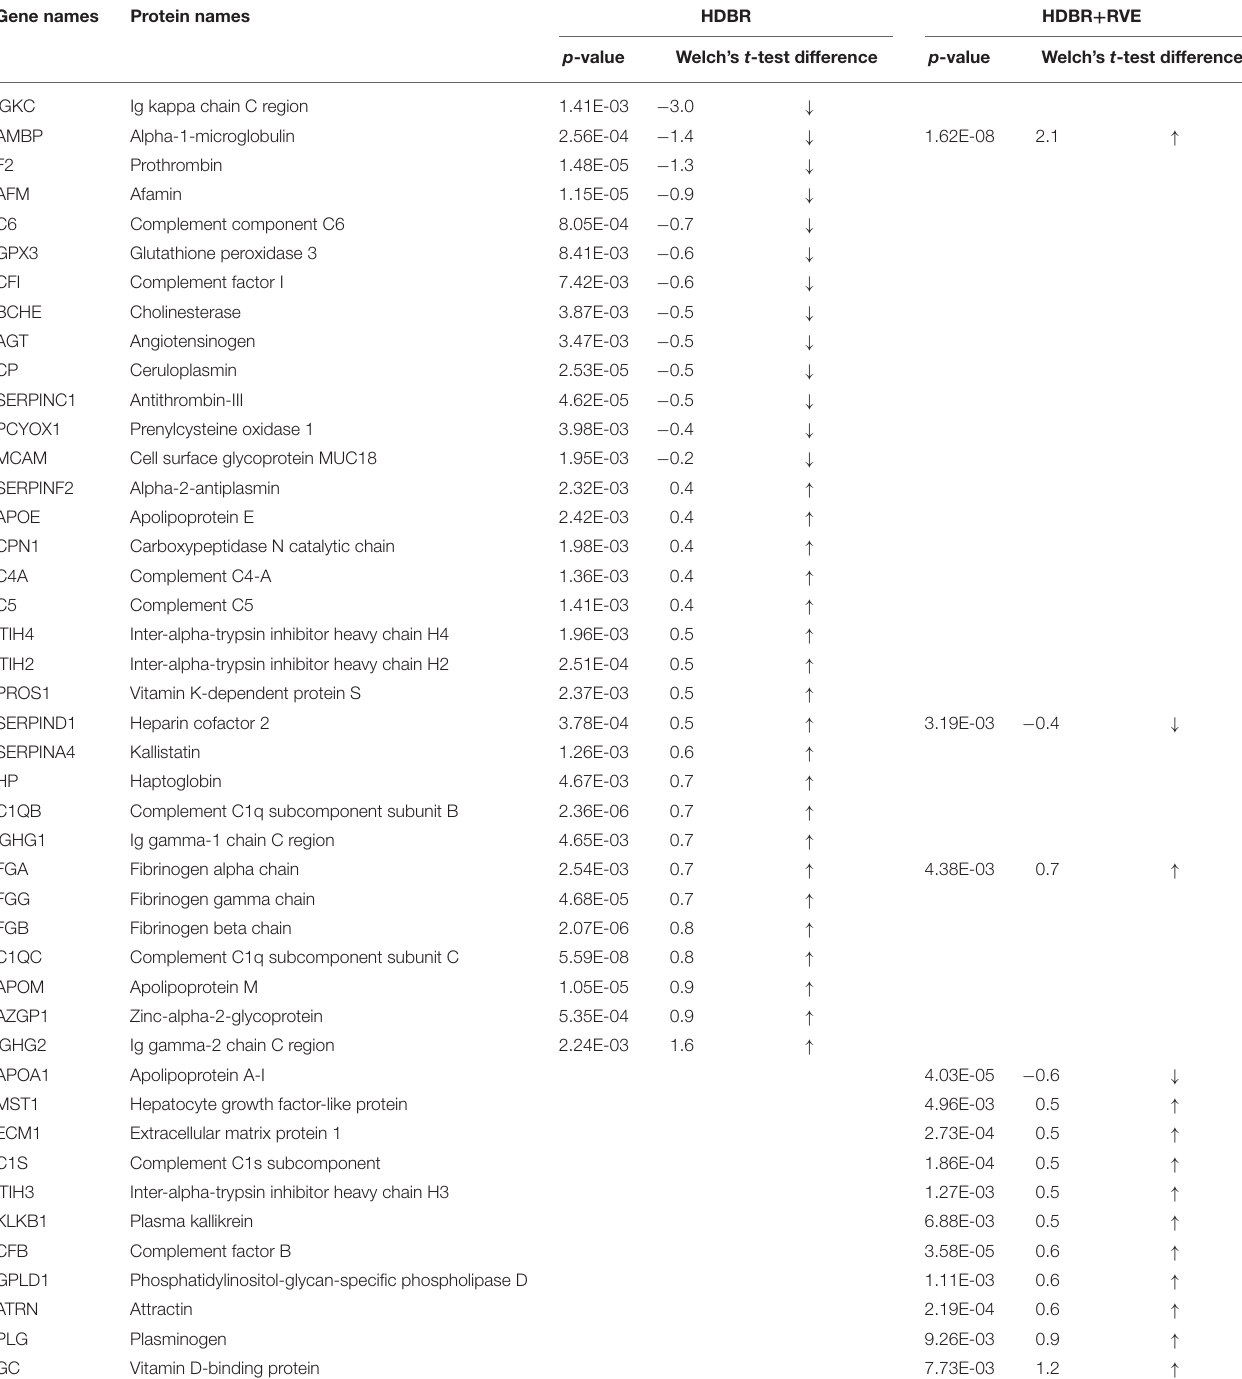
TABLE 1 | Proteins are significantly different from the summary background during head-down bed rest without countermeasures (HDBR) and with resistive vibration exercises (HDBR +